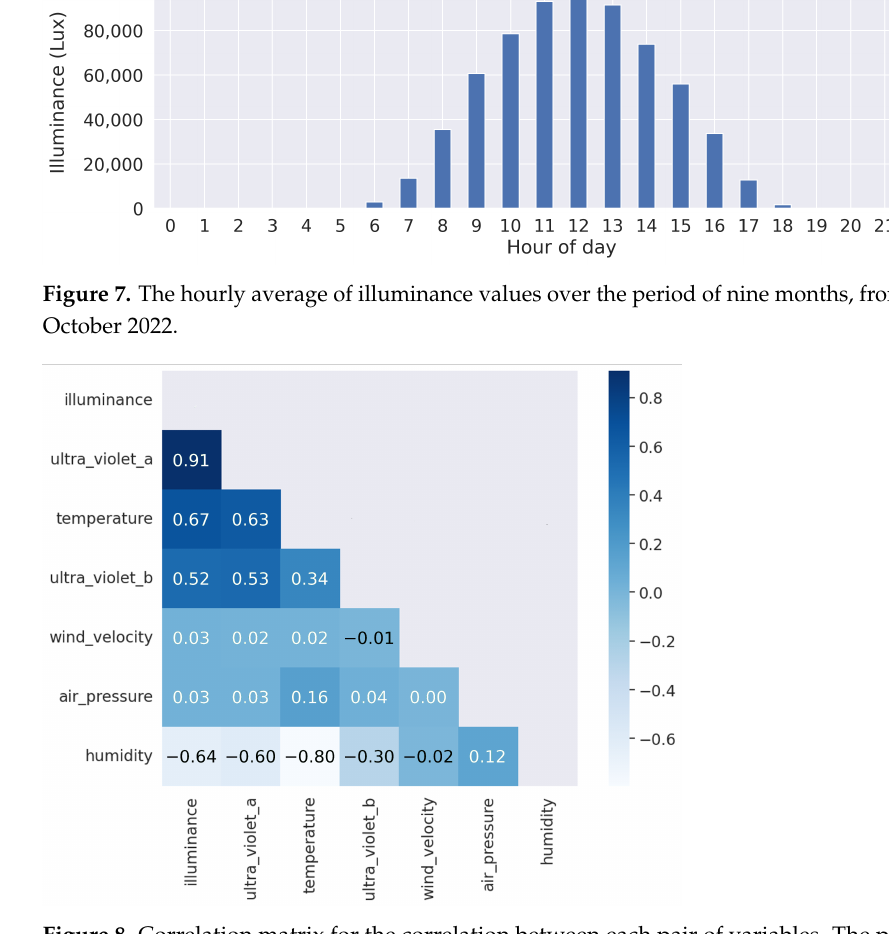
Figure 8. Correlation matrix for the correlation between each pair of variables. The positive strong correlation between Ultraviolet A and illuminance values was